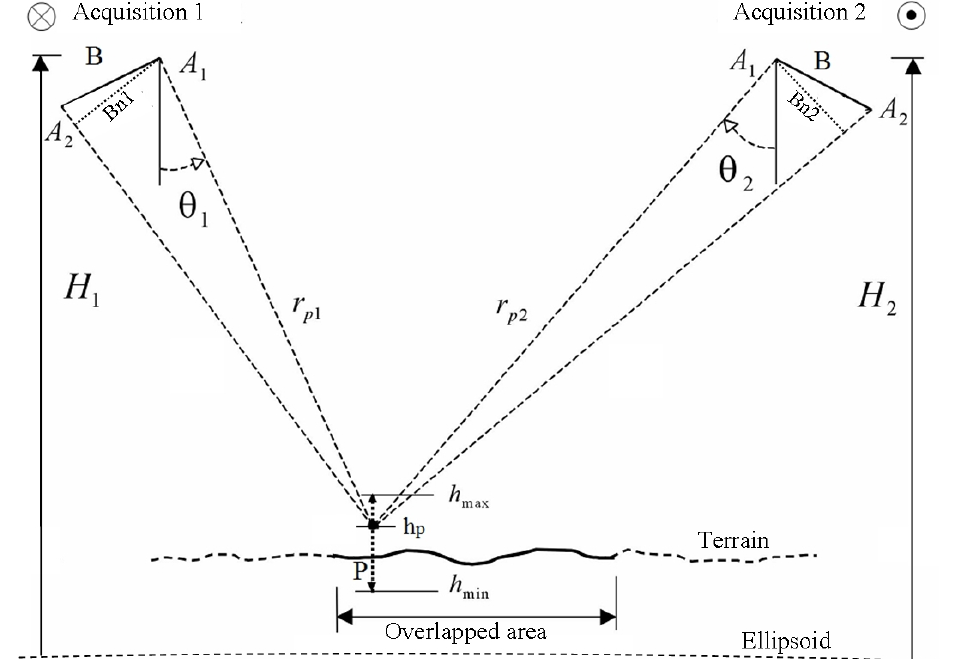
Figure 2. Acquisition mode of airborne InSAR system for systematic